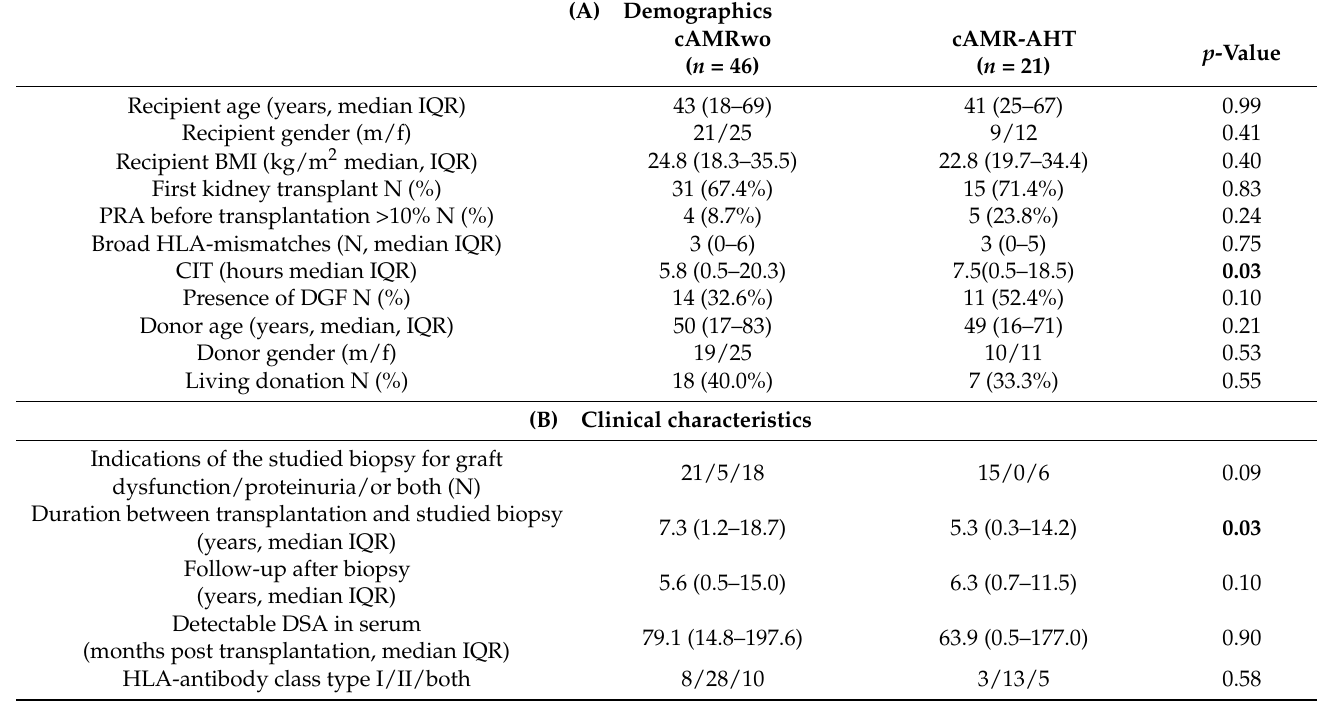
Table 1. Demographics and clinical characteristics of patients with